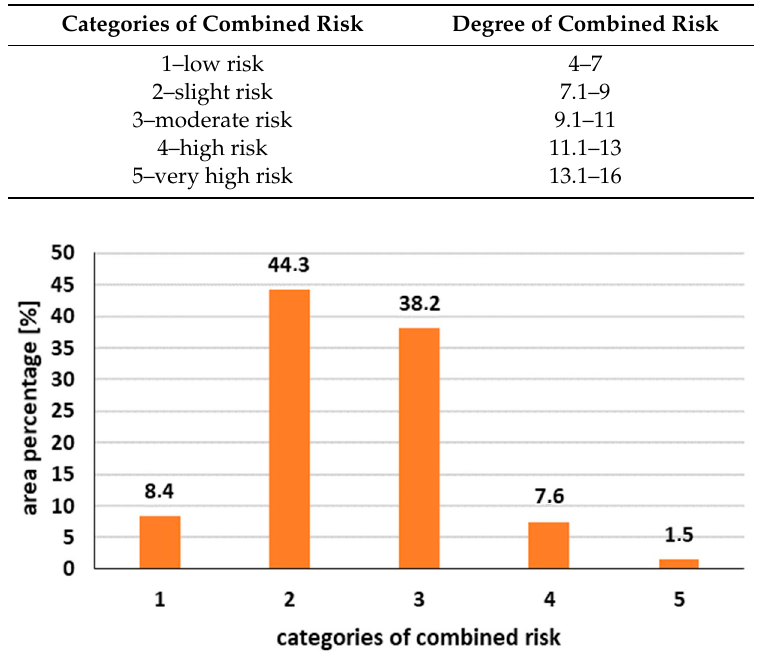
Table 10. Characterization of categories of combined risk in terms of their degree of combined risk (based on Table 9).